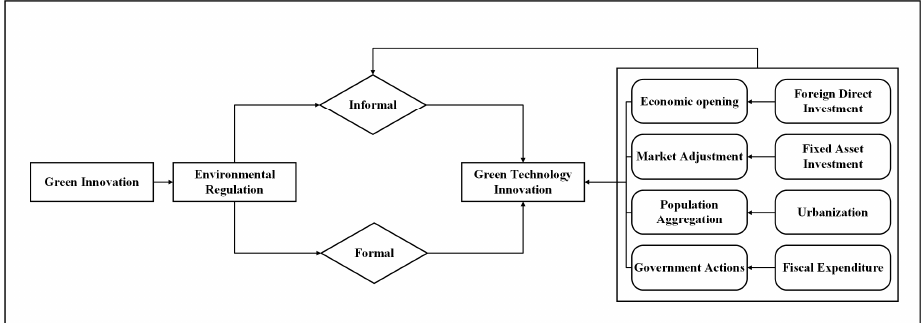
Figure 1. Variable association diagram.